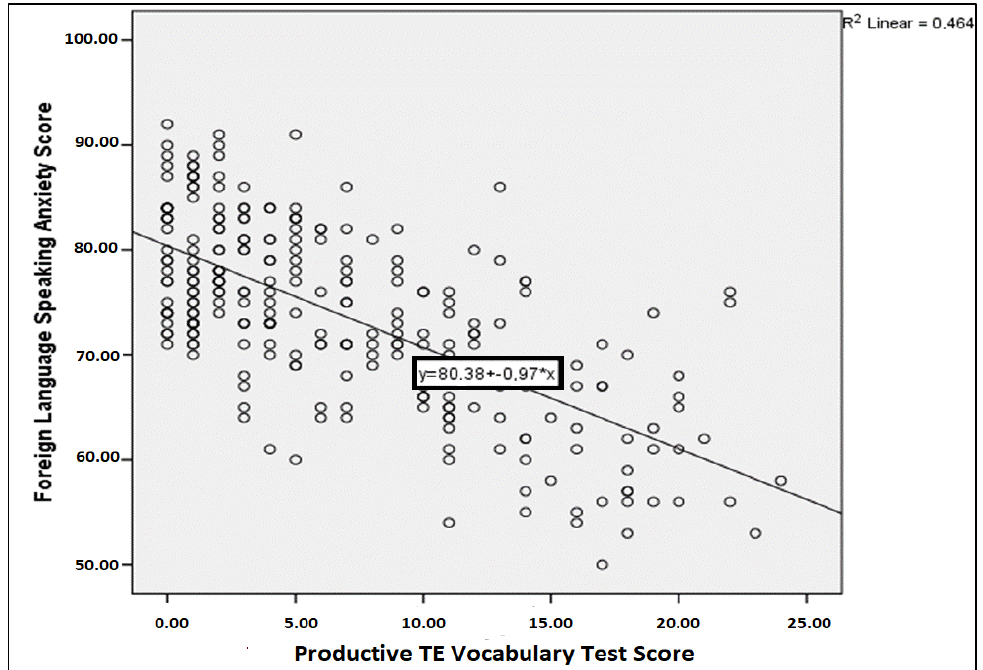
Figure 3. Scatterplot of linearity of the productive TE vocabulary test and FLSA.